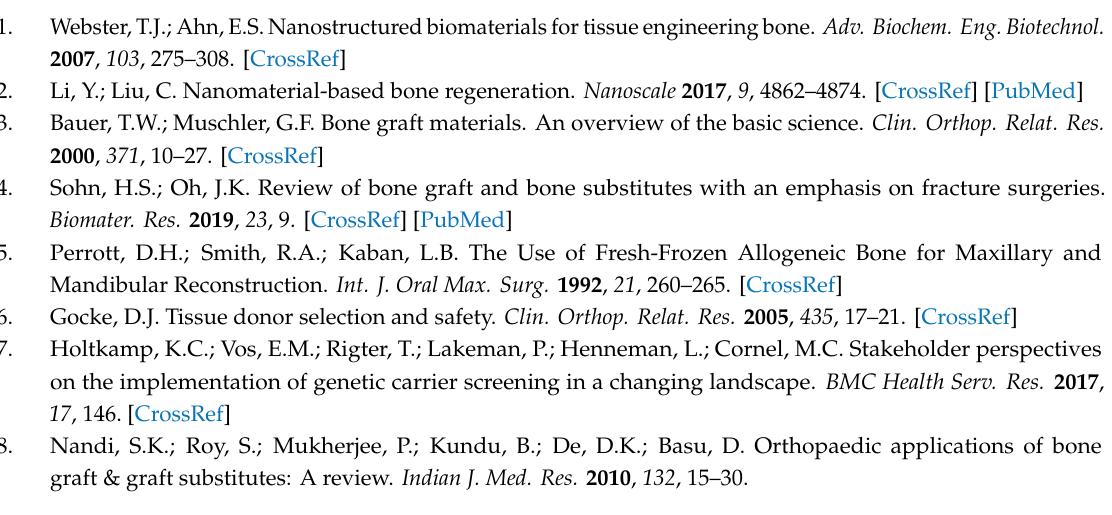
Table S1: Real-time PCR primer sequences of the osteogenic-related